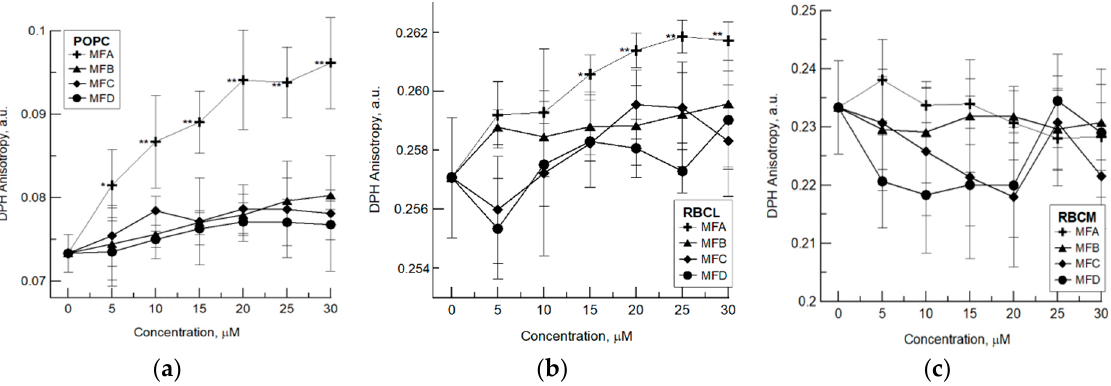
Figure 2. The changes in anisotropy of DPH probe observed under the influence of MFA, MFB, MFC, and MFD compounds in liposomes formed from: ( a ) 1-palmitoyl-2-oleoyl-glycero-3-phosphocholine (POPC); ( b ) lipids extracted from erythrocyte membrane (RBCL); ( c ) in red blood cell membrane (RBCM). The experiment was carried out in three replicates, the results were presented as mean ± standard deviation. Statistically significant differences between modified and control membranes are marked: * α = 0.05; ** α = 0.01.